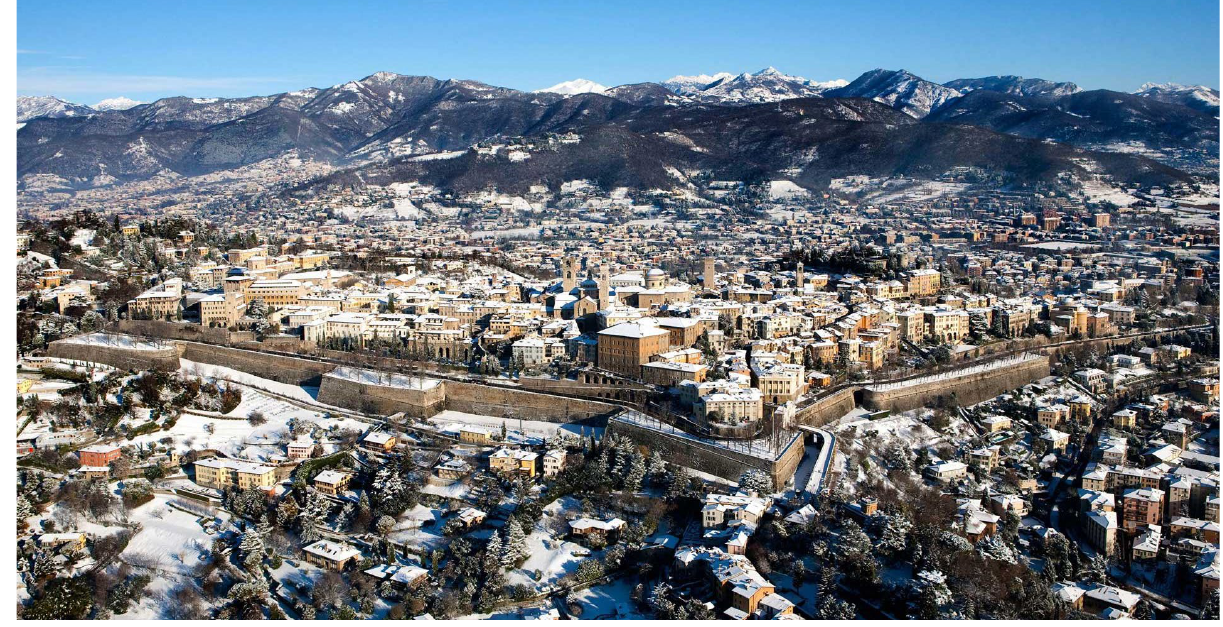
Figure 1. The Bergamo city walls in a winter view from South, facing St. James’